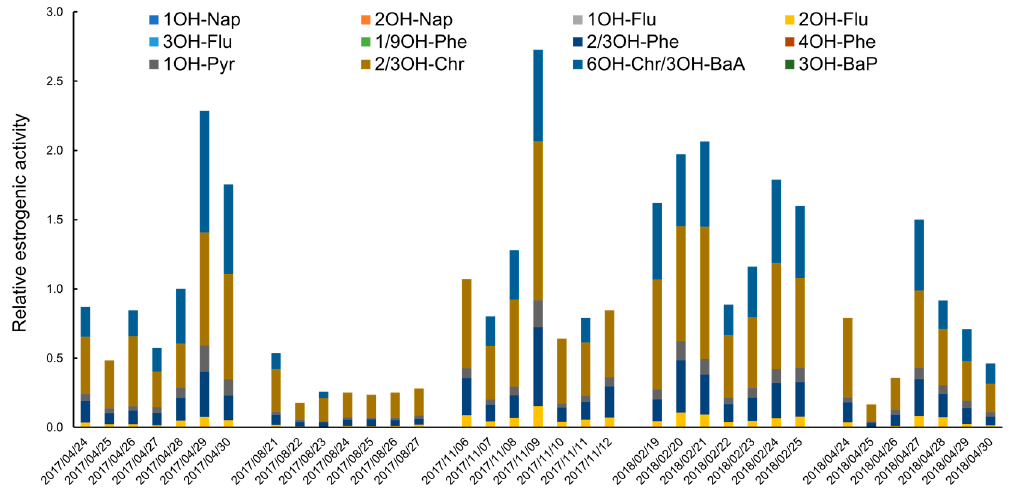
Figure 5. Daily relative estrogenic activities of atmospheric OH-PAHs in April, August, and November 2017, and February and April 2018 in Kanazawa.